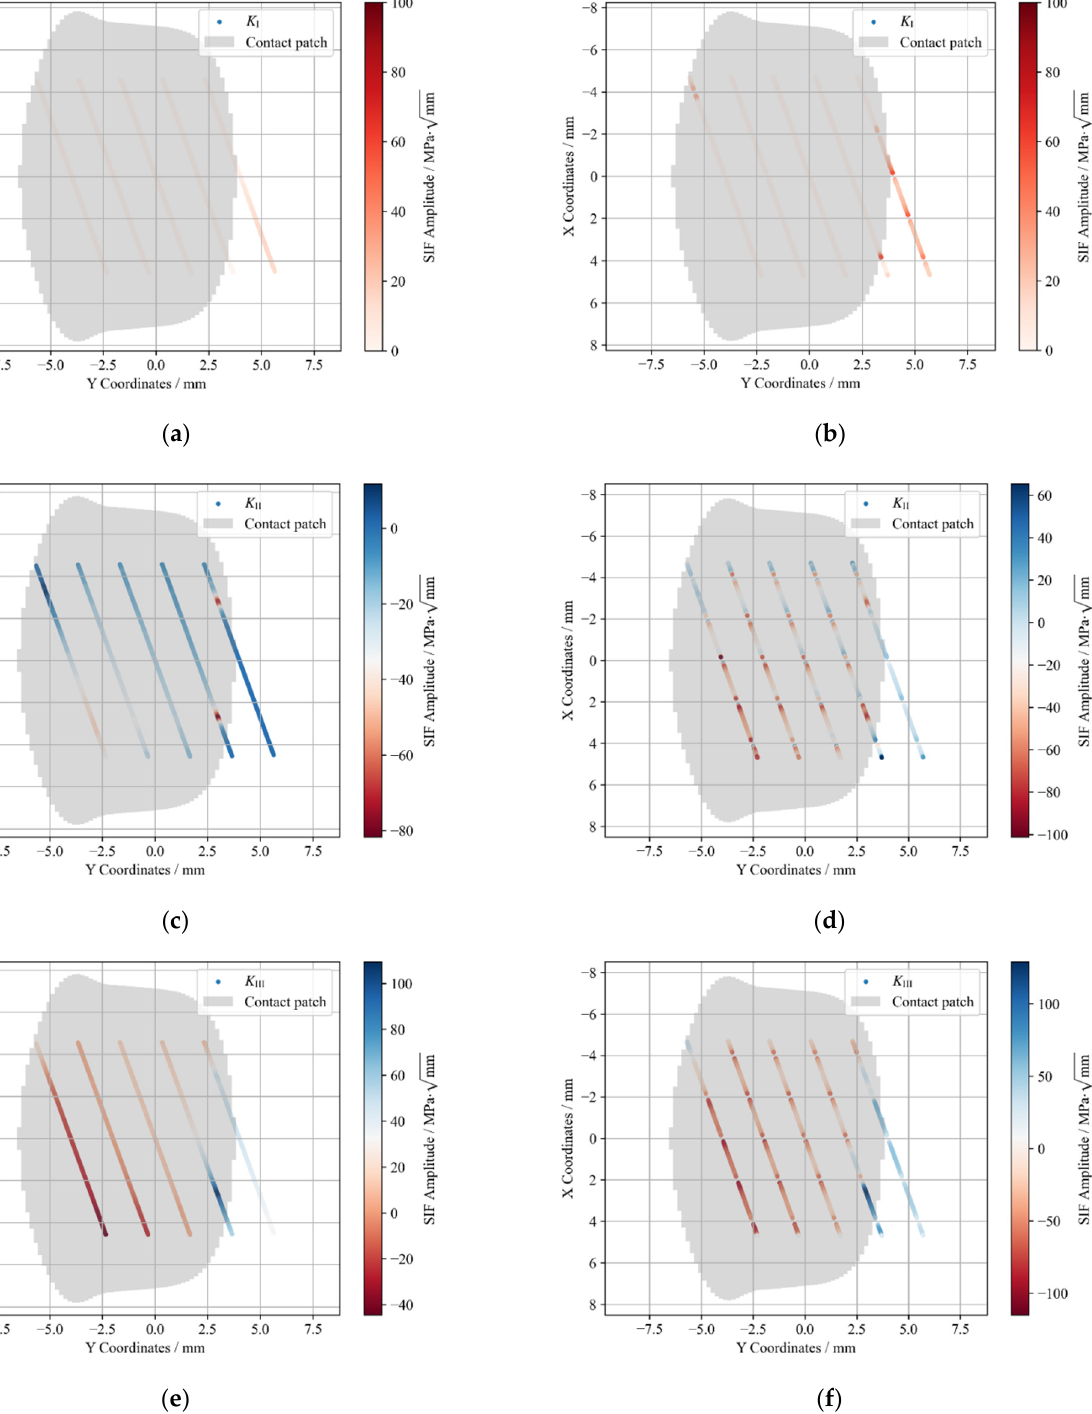
Figure 13. Results of SIFs at the circular curve: ( a ) SIF of type I cracks without the grinding marks; ( b ) SIF of type I cracks with the grinding marks; ( c ) SIF of type II cracks without the grinding marks; ( d ) SIF of type II cracks with the grinding marks; ( e ) SIF of type III cracks without the grinding marks; ( f ) SIF of type III cracks with the grinding marks.